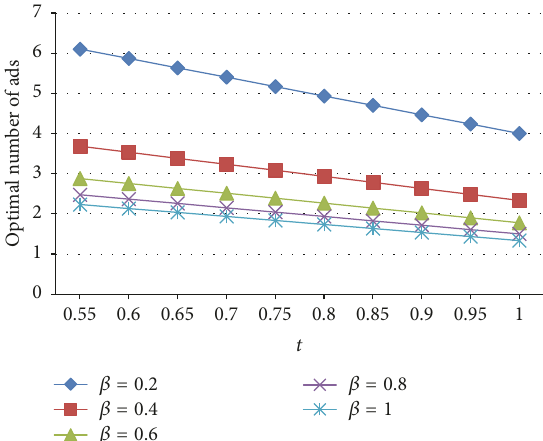
Figure 1: The optimal number of ads with respect to time 𝑡